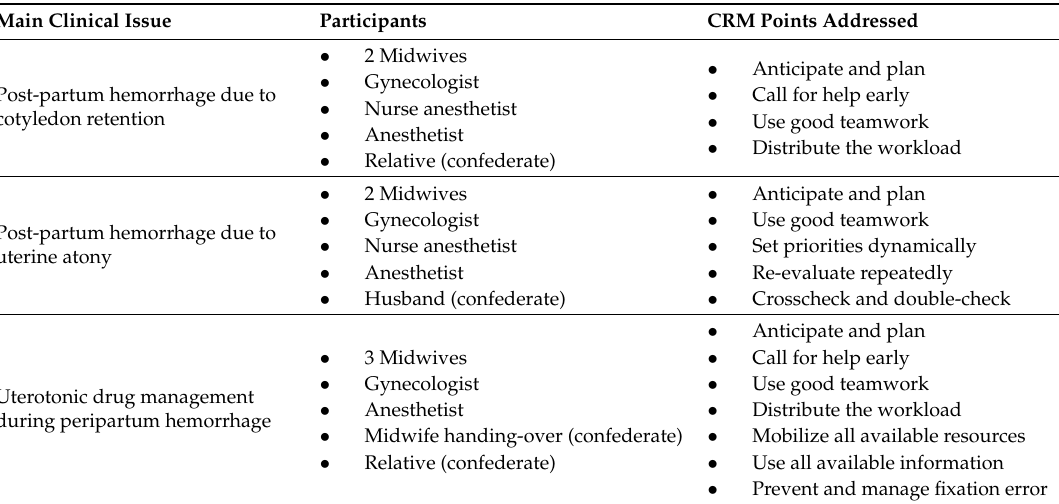
Table 2. The three scenarios used in the